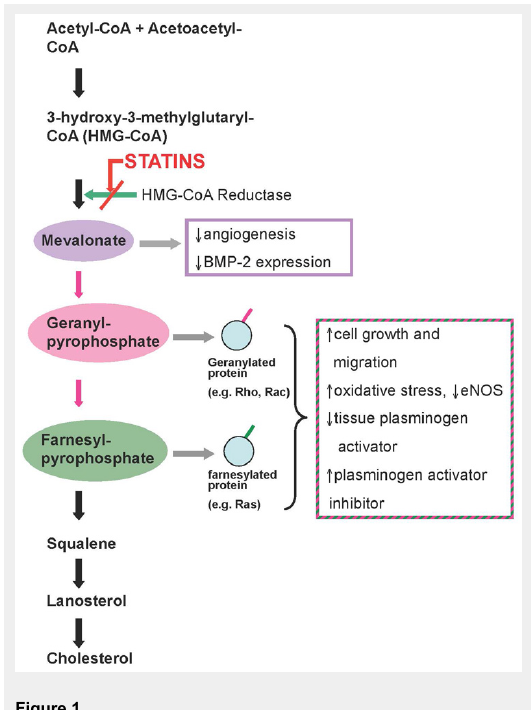
Essential steps of cholesterol biosynthesis . Pink arrows indicate that several intermediate molecules are not depicted. Statins inhibit the rate-limiting step of cholesterol synthesis, which is catalysed by HMG-CoA reductase. Pleiotropic statin effects are mediated by mevalonate and prenylated signaling molecules (Rho, Rac, Ras), as indicated in colored boxes. BMP-2, bone morphogenetic protein-2. e-NOS, endothelial nitric oxide synthase. Adapted, with permission, from Rutishauser J, Schweiz Med Forum. 2008;8(10):187–90,